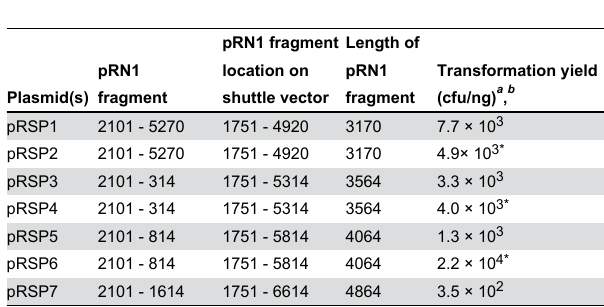
Table 2. Transformation efficiency of constructed shuttle vectors into S. acidocaldarius E4-39